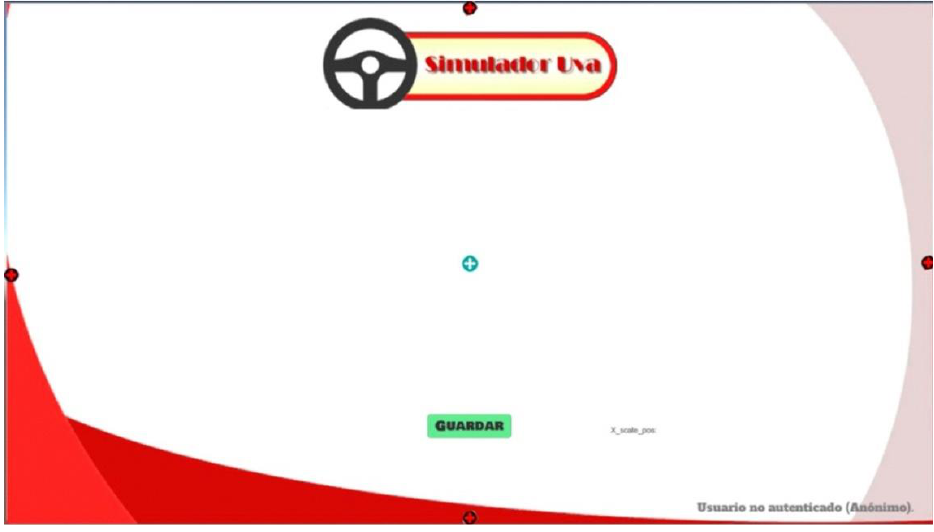
Figure 5. Calibration points in method 1.